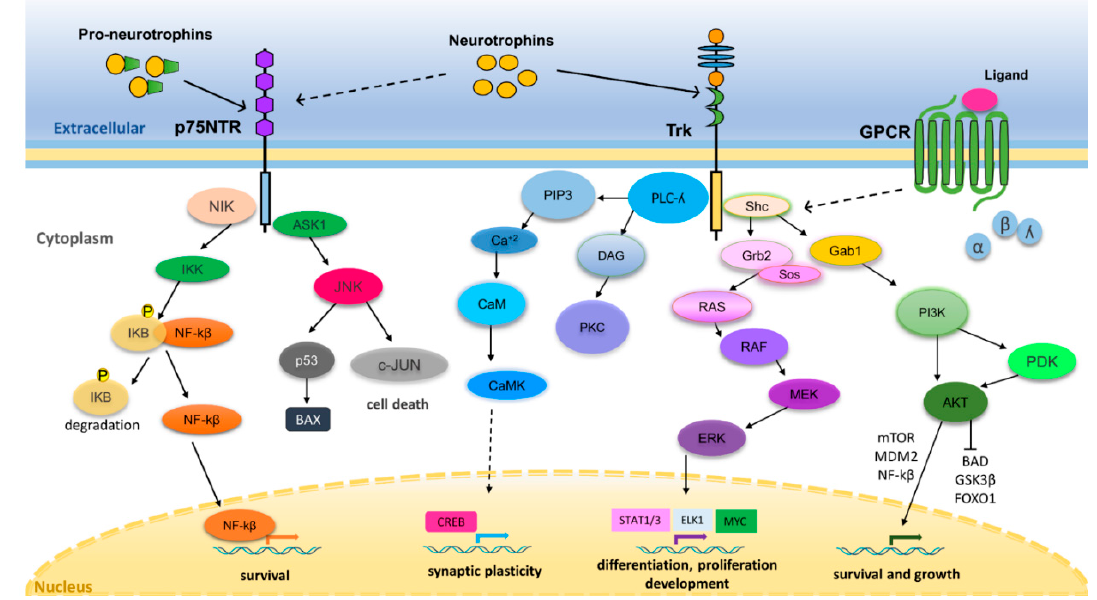
Figure 1. Signaling mechanisms mediating the actions of neurotrophins. Neurotrophin/Trk signaling involves neurotrophin binding to Trks, leading to receptor dimerization, autophosphorylation of tyrosine residues, and the recruitment of cytosolic adaptor proteins such as Src homology collagen protein (Shc). Shc recruits the adaptor growth factor receptor-bound protein 2 (GRB2) which is linked to the Ras exchange factor son of sevenless (SOS) leading to the activation of a RAS- MAPK pathway (RAS-RAF-MEK-ERK). Activated extracellular-regulated kinase (ERK) translocates to the nucleus and transactivates transcription factors such as STAT1/3, Elk1, and Myc, modulating gene expression to induce proliferation, differentiation or development. Shc can also recruit GRB2-associated-binding protein 1 (Gab1), driving activation of the PI3K-PDK1-Akt cascade. Phosphorylated Akt can regulate